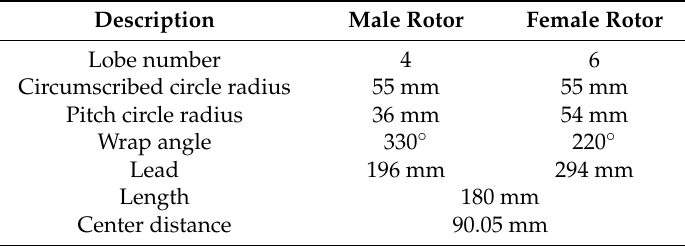
Table 2. Specifications of the rotor profile.